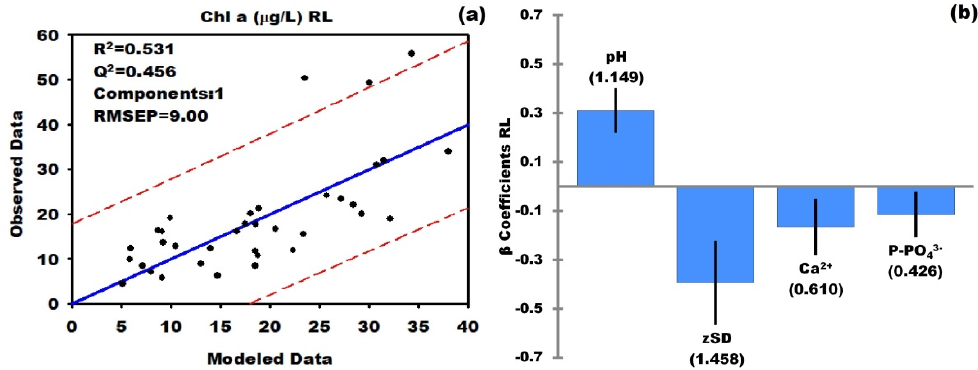
Figure 6. ( a ) RL Chl a modeled vs. observed data, regression line (solid line), 95% prediction confidence intervals (dashed lines), and model performance metrics; ( b ) RL β coefficients for retained variables (bars), confidence intervals (solid lines), and VIP in parentheses.